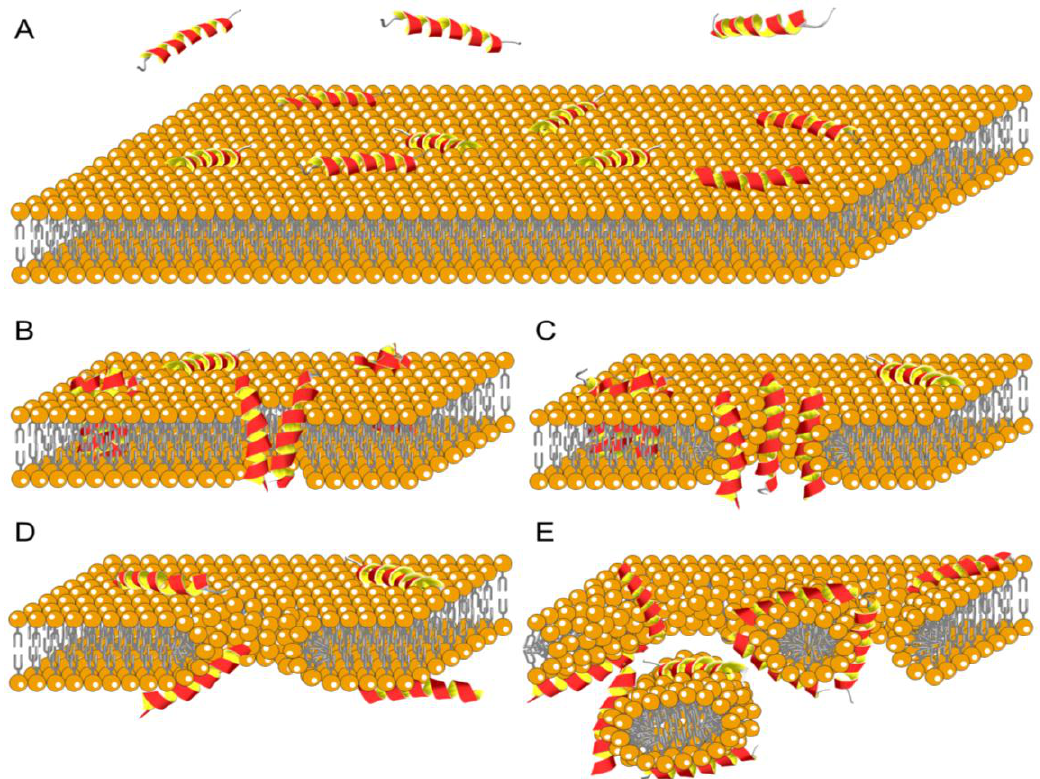
Figure 8. Proposed pathways for peptide interaction and disruption of lipid bilayers. The